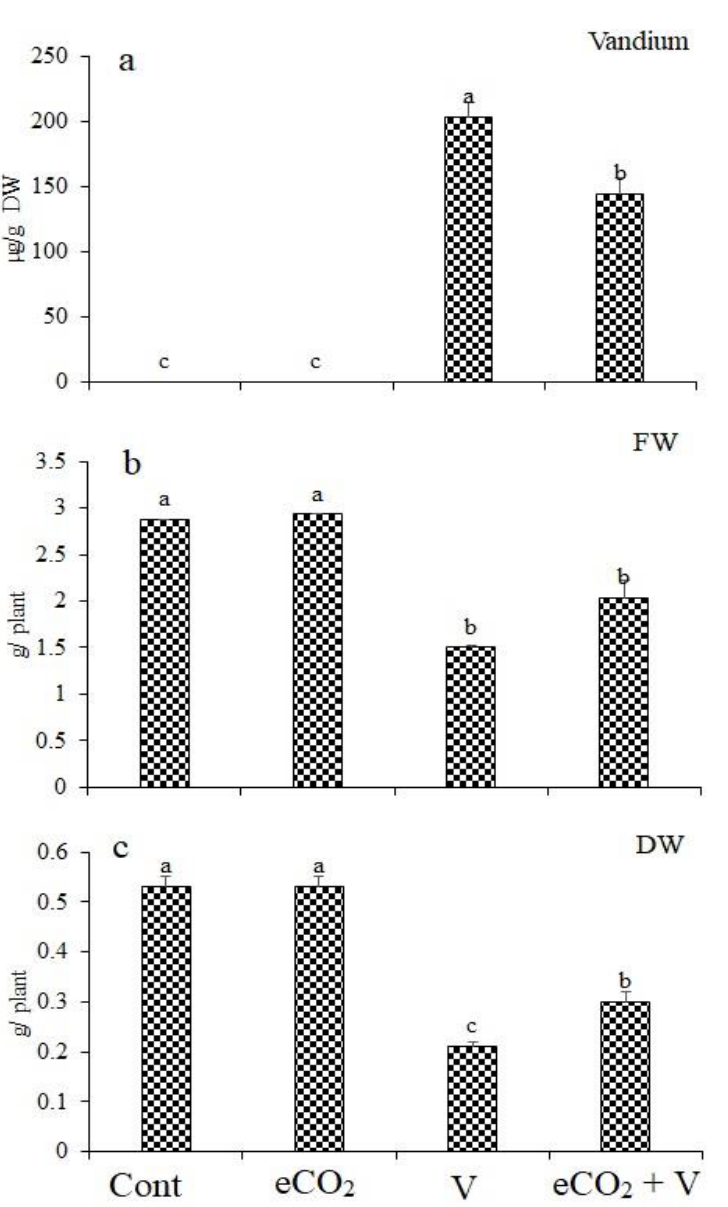
Figure 1. Effect of elevated CO 2 , vanadium (V) and their combination on ( a ) vanadium concentration, ( b ) fresh weight (FW) and ( c ) dry weight (DW) of wheat. Cont.: ambient CO 2 (410 ppm); eCO 2 : (620 ppm), V:350 mg/kg soil. The aforementioned information is presented as mean values with standard error ( n = 4). One-way ANOVA and the Tukey posthoc test were used to statistically examine the data and compare the means. Different letters denote statistically significant differences between the means of the same plant species, at least at the 0.05 level of significance.